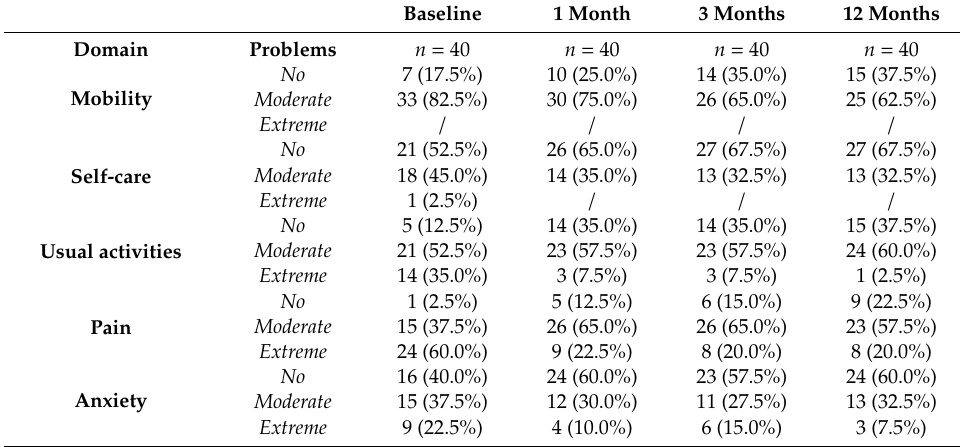
Table 4. Summary of reported problems in each domain of the EQ-5D-3L in patients with complete